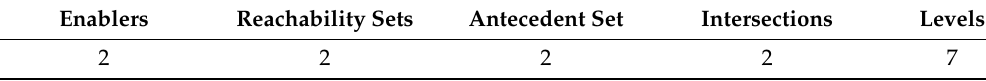
Table 12. Level partitions for enablers—Iteration 7.